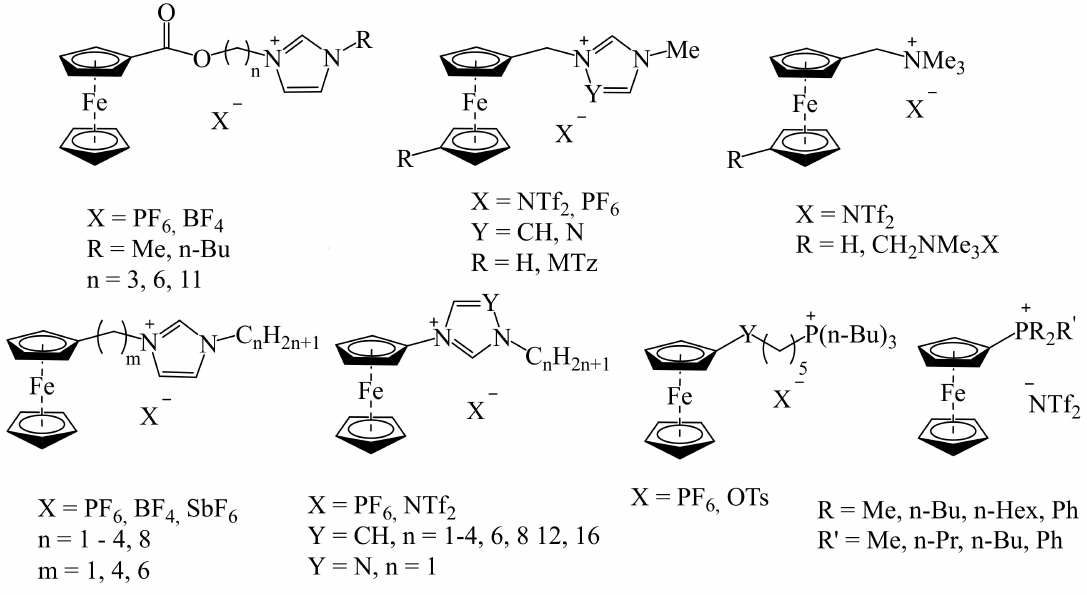
Figure 1. Ferrocenyl (Fc)-containing onium compounds [5–10].